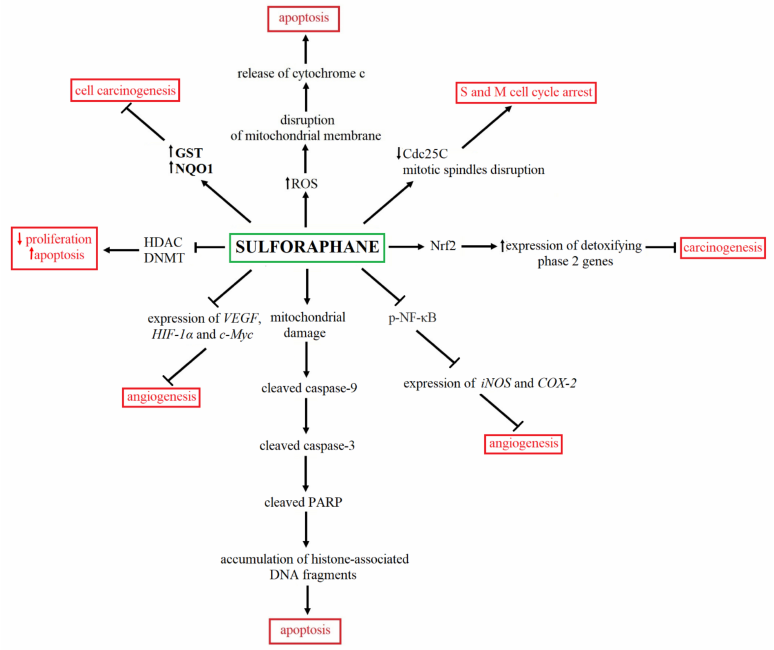
Figure 2. The summary of anticancer effects and mechanism of SFN action. SFN may modulate numerous signaling pathways, including angiogenesis [55], cell carcinogenesis [47–50,56,57], cell proliferation [54] and cell cycle [51,52] as well as apoptosis